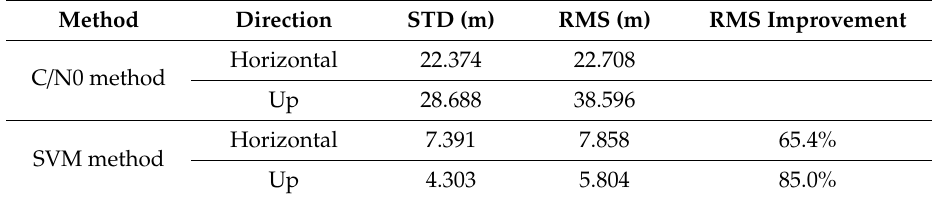
Figure 7. SFPPP positioning error in time series ( A ), and positioning error cumulative distribution functions ( B ) of the two methods. Table 4. Positioning accuracy improvement compared to traditional C / N0 weight model.